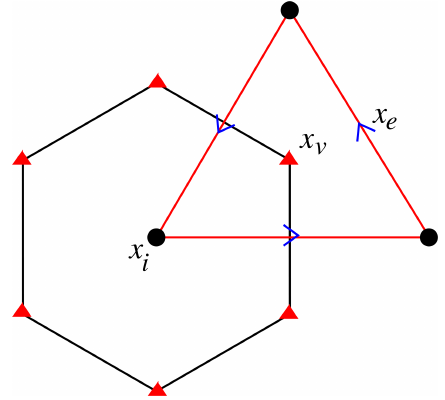
Figure 1. The regular C grid on the plane. Vorticity is located on the primal grid of triangles at points x v and mass located on the dual grid of hexagons at nodes x i . The velocities/fluxes are located on edges x e . A multiscale hierarchy of nested refined C grids is generated by bisecting the triangle